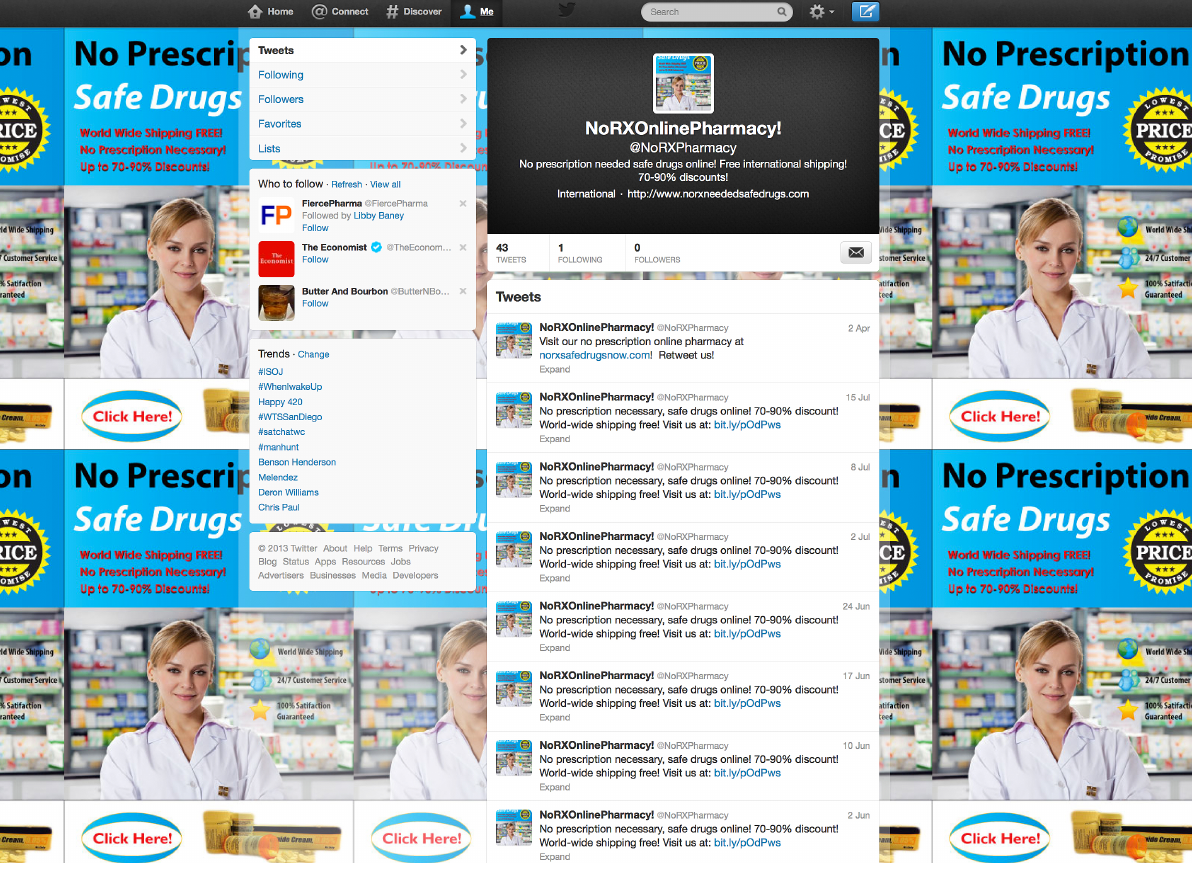
Figure 3. Twitter eDTCA